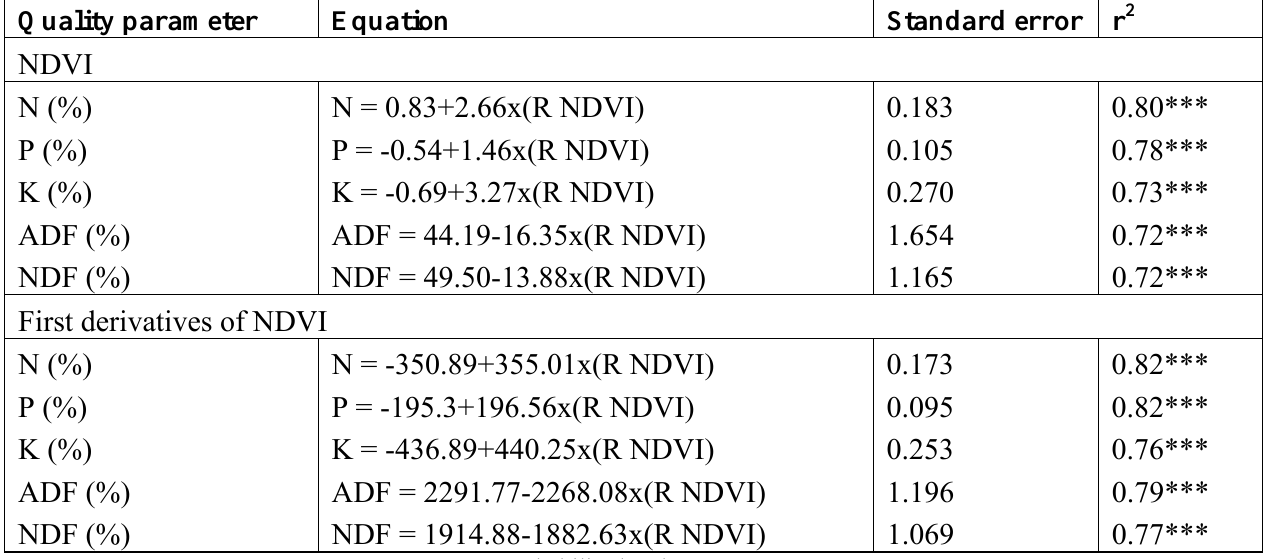
Table 3. Relationships between NDVI and nutrition contents in sainfoin